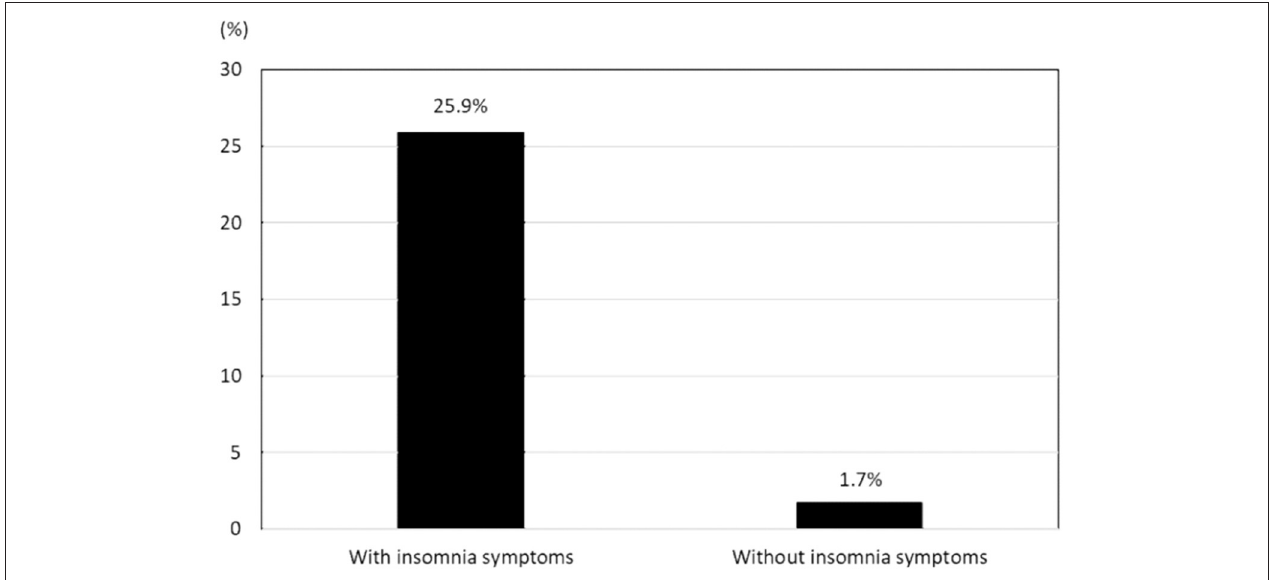
FIGURE 2 | Prevalence of depressive symptoms in participants with insomnia symptoms and those without insomnia symptoms.